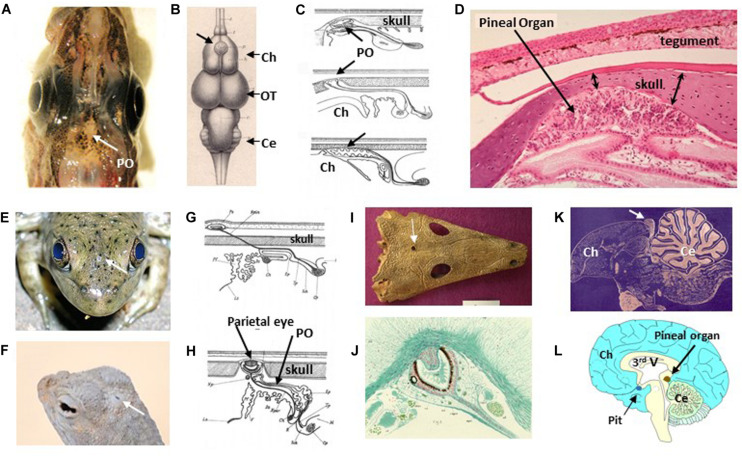
Extraretinal photoreception in vertebrates. (A) Dorsal view of the head of the Polar Cod Boreogadus saida; the pineal organ (PO) is located in the sagittal axis just behind the eyes in an area with unpigmented meninges (@JackFalcón). (B) Dorsal view of the brains of the Red Mullet Mullus surmulletus showing the location of the pineal organ (thick arrow), located in between the two cerebral hemispheres (Ch); OT, optic tectum; Cer, cerebellum; from Baudelot (1883) (no permission required). (C) Schematic sagittal sections through the epithalamus area of, from top to bottom, lampreys, chondrichtyens and teleost fish; from Studnicka (1905). Note that the skull above the pineal organ is thinner, as also seen in panel (D) (no permission required). The histological sagittal section is from the Sea Bream Sparus aurata; the pineal is located in a kind of large pit below the skull (note that the tegument above also appears thinner) (gift from Professor J.A. Muñoz Cueto, Cadiz, Spain). (E,F) Head dorsal views showing the spot position of the frontal organ in the American Bullfrog Rana catesbeiana (E) and the parietal eye of the Zebra-tailed Lizard Callisaurus draconoides (F) (arrows) (@JackFalcón). (G,H) Schematic sagittal sections through the epithalamus areas of frogs (G) and lizards (H); the pineal organs are located below the skull, while the frontal/parietal eyes are located in the skin connected to the brain by a stalk (Studnicka, 1905) (no permission required). (I) Dorsal fossil skull of the ancestral amphibian Thoosuchus jakovlevi showing the location of the frontal organ hole just equidistant from the eyes (with permission from https://commons.wikimedia.org/wiki/File:Thoosuchus_jakovlevi.JPG). (J) The pineal eye of the tuatara Sphenodon punctatus resembles a simplified retina with an eye cup and a lens-like structure; sagittal section from Dendy (1911) (no permission required). (K) In the avian brain the pineal organ form a gland in between the cerebral hemispheres and the cerebellum (gift from Professor J.P. Collin). (L) In humans the gland is located deep in the brain (@JackFalcón).